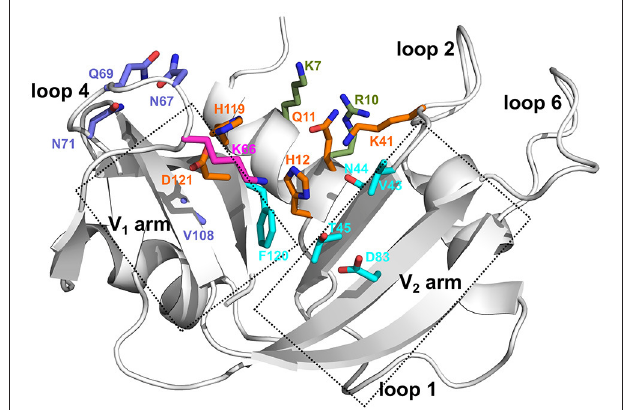
FIGURE 1 | Ligand binding subsites identified in bovine RNase A. Residues of the ligand binding subsites, corresponding to the base B 1 , B 2 , and phosphate P 0 , P 1 , and P 2 subsites are represented as sticks colored cyan, purple, magenta, orange, and olive, respectively. Catalytic residues His12, Lys41, and His119 form part of the P 1 binding